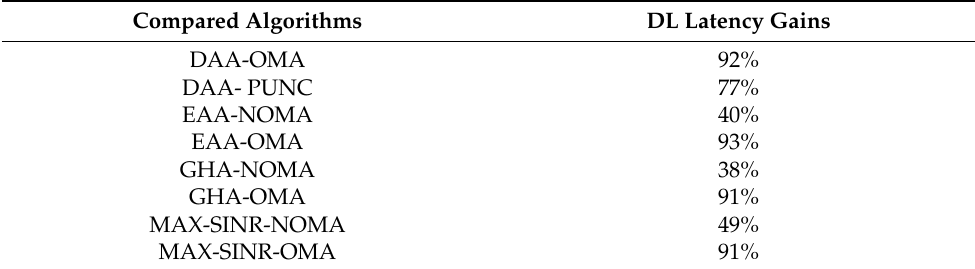
Table 7. DL latency gains for uRLLC